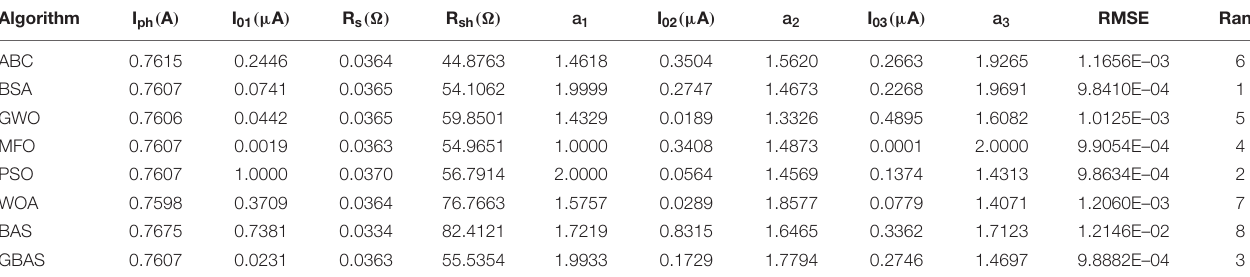
TABLE 11 | Model parameters identified by various algorithms for triple diode model